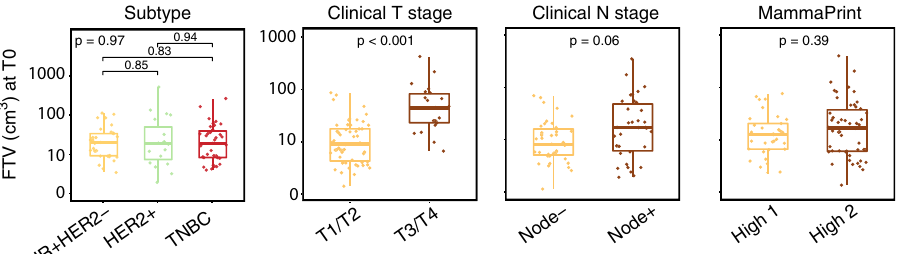
Fig. 1 Pretreatment functional tumor volume (FTV) and association with clinicopathologic characteristics. P values were calculated using Mann – Whitney (2 groups) or Kruskal – Wallis test (3 groups). For each box plot, the center line, the boundaries of the box, the ends of the whiskers and points beyond the whiskers represent the median value, the interquartile range, the minimum and maximum values, and the outliers,